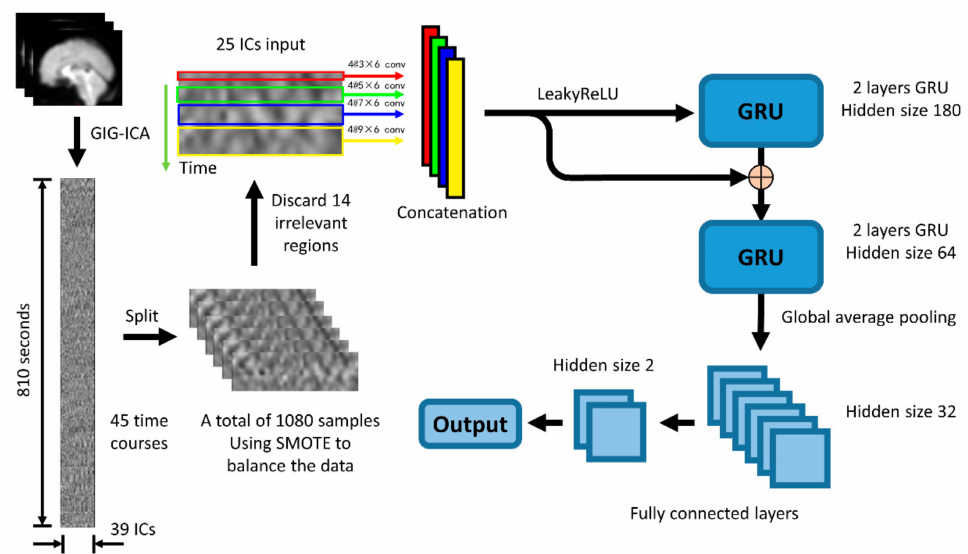
Figure 4. The basic structure of the convolution-GRU model is to combine the spatial features obtained by convolution at four di ff erent time scales and send them to the GRU to learn the temporal features. Considering that negative values may appear in the process of convolution, the LeakyRelu layer is selected to ensure the learning of parameters. It should be noted that the number before the @ sign in this figure means the number of the channels of the convolution